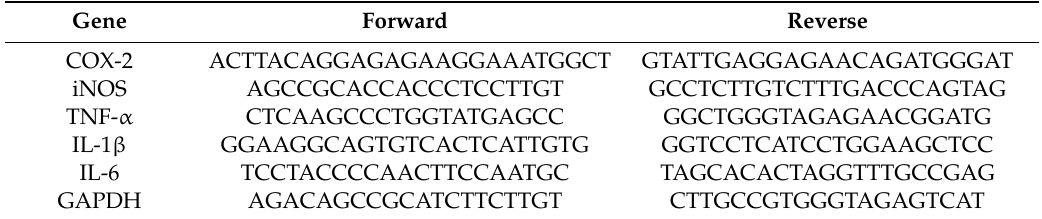
Table 1. The primers sequences for PCR